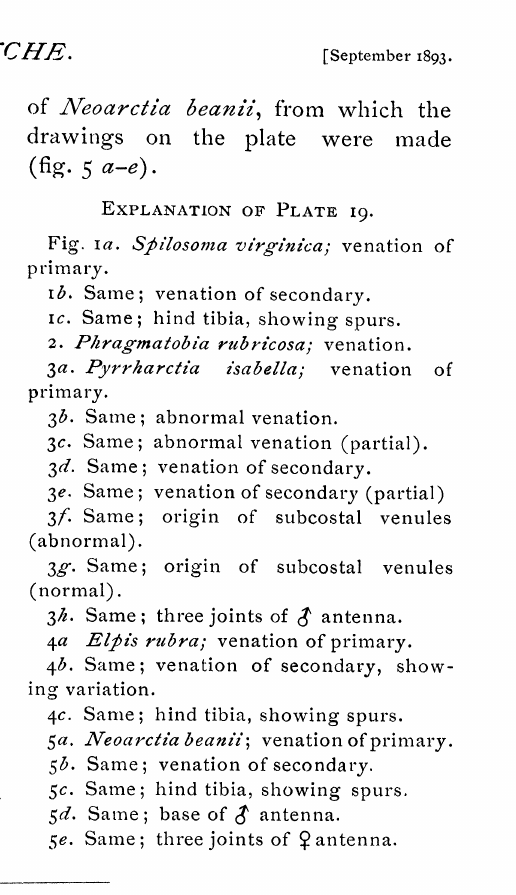
Fig. Ia. S3ilosoma virglnica; venation of